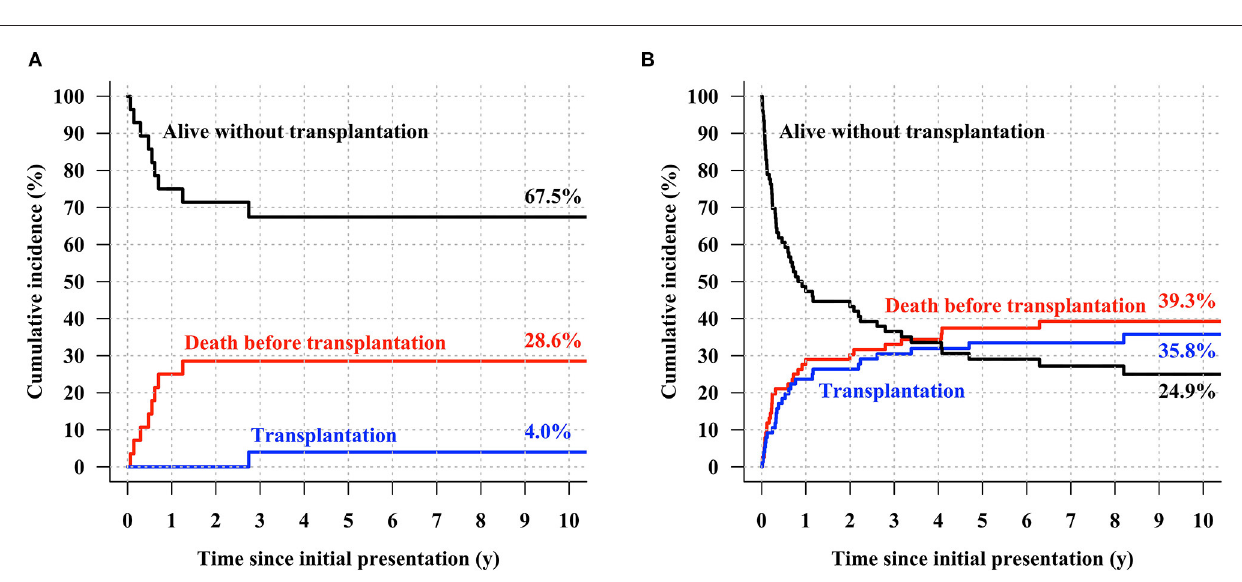
FIGURE 8 | Cumulative incidence of transplantation-free survival, death before heart transplantation, and heart transplantation in (A) the low-risk group and (B) high-risk